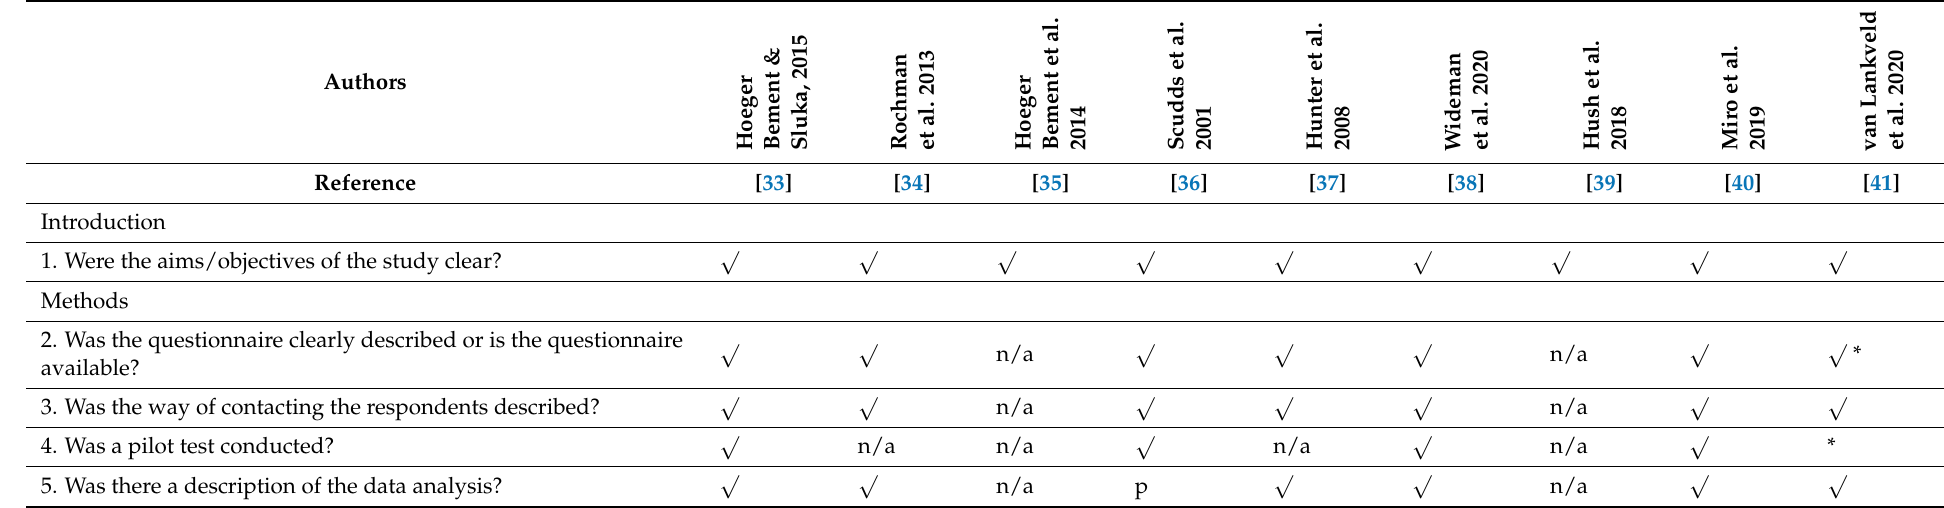
Table 2. Critical Appraisal of the studies included in the scoping